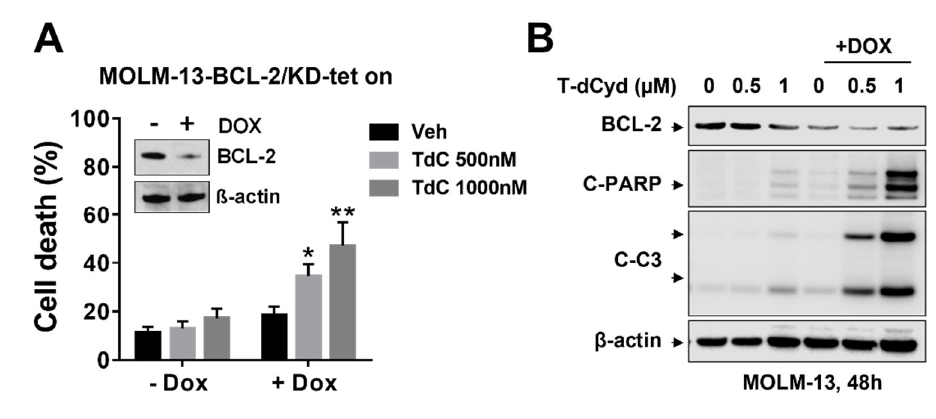
Figure 2. Dox−inducible TET−on MOLM−13 cells expressing BCL−2 shRNA were exposed to the indicated concentrations of T−dCyd in the presence or absence of doxycycline. Cell death was determined by annexin V/PI staining and FCM. Inset: expression of BCL−2 by WB with or without doxycycline. * ( p < 0.05) and ** ( p < 0.01) = significantly greater than values for cells without doxycycline ( A ); cleaved PARP and Caspase 3 were detected by WB ( B ).